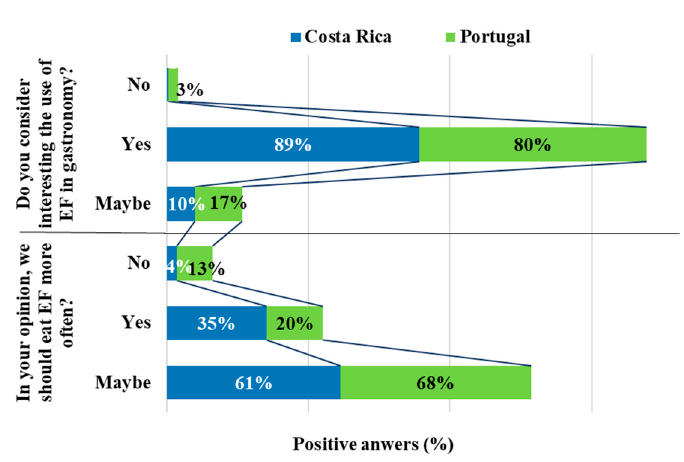
Figure 8. Opinions about the use of EF for culinary purposes.